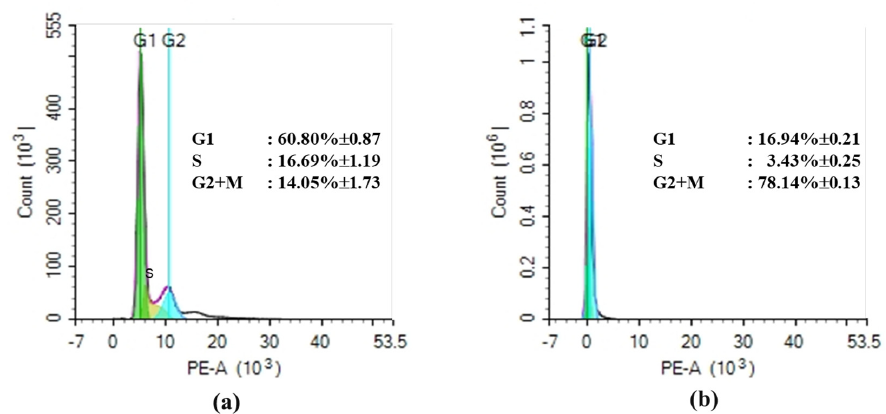
Figure 6. Effect of the ethanol fraction of clove bud on the cell cycle of S. pombe. Yeast cells were treated with ( a ) FEB (8 µ g · mL − 1 ) and ( b ) without fraction. The total amount of each yeast cell phase was mentioned in the right corner of each figure. All figures and data are means and representative from three independent